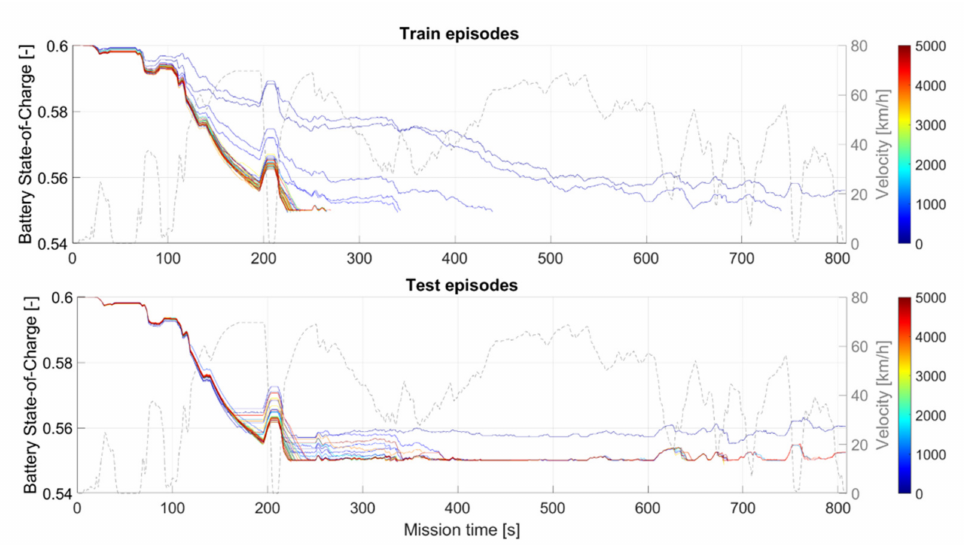
Figure 9. Battery SoC obtained with Q-learning in case of null discount factor during training and testing